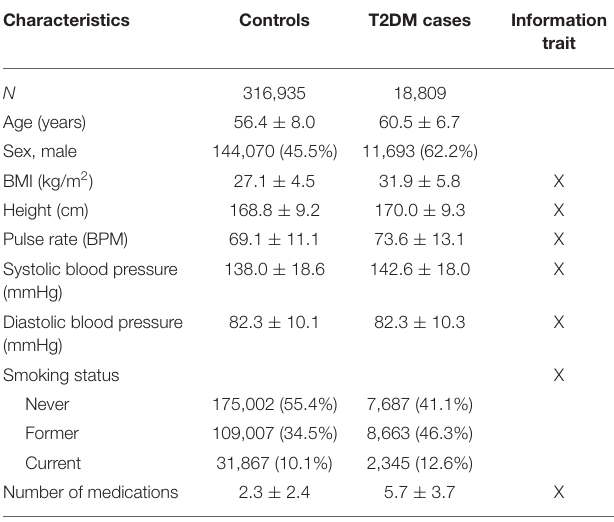
335,652) of T2DM cases and controls = standard ±